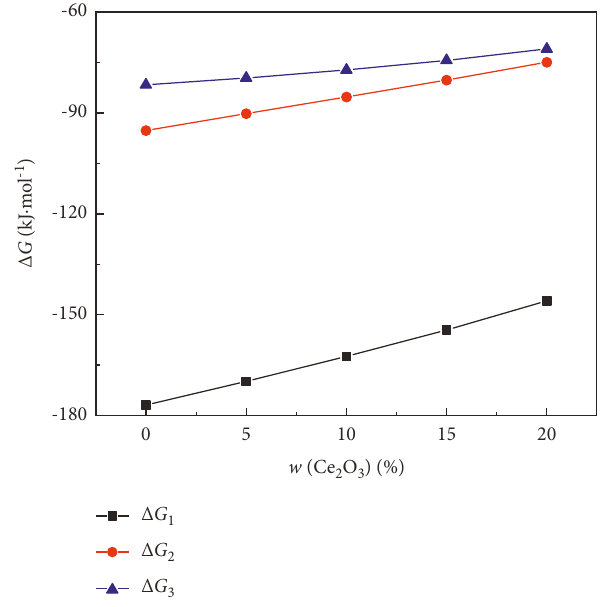
Figure 3: Gibbs free energy of the slag-steel interface chemical reaction with different Ce 2 O 3 contents.